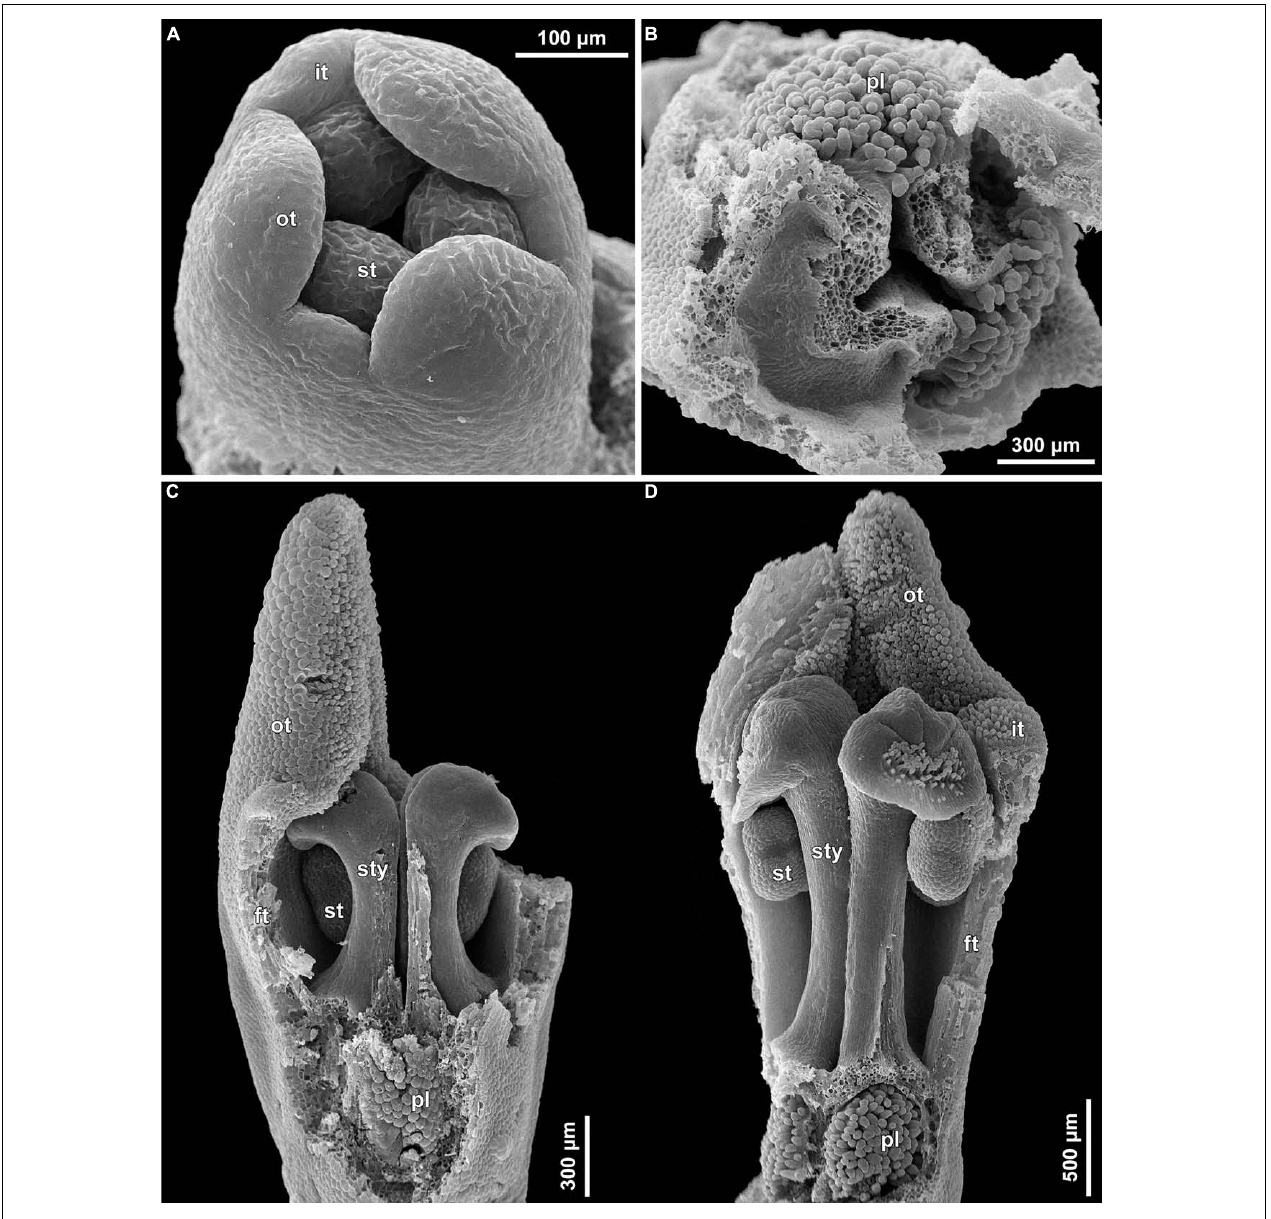
FIGURE 14 | Floral development of Burmannia itoana (SEM). (A) Flower before initiation of gynoecium. (B) Ovary, top view; styles removed; ovary wall and roof in two of the three carpels removed. (C,D) Flowers before (C) and after (D) postgenital fusion of styles, longitudinal sections. ft, floral tube; it, inner tepal; ot, outer tepal; pl, placenta; st, stamen; sty, style.